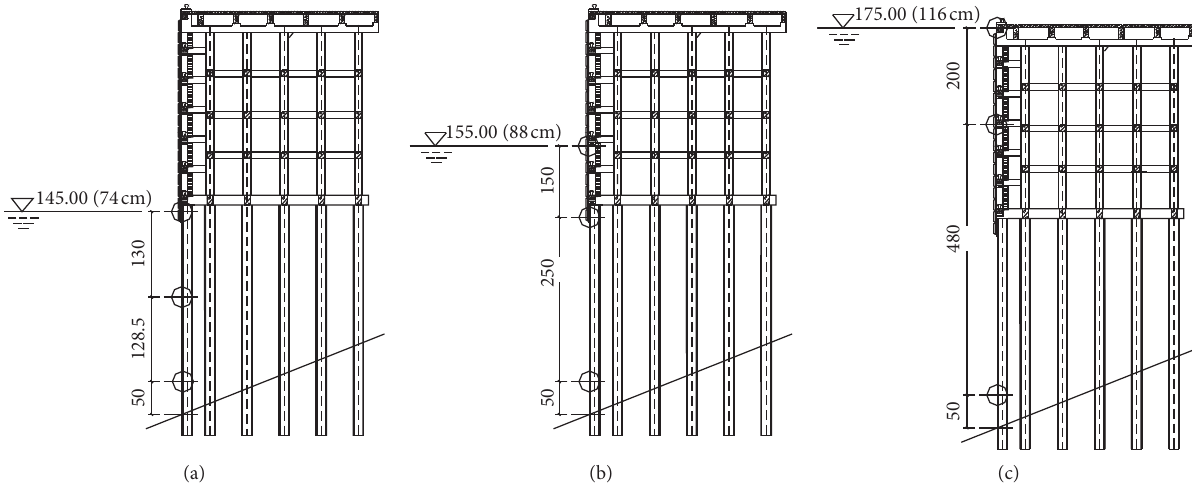
Figure 4: Side view of the location of wave pressure sensor at (a) 74cm water depth, (b) 88cm water depth, and (c) 116cm water depth.